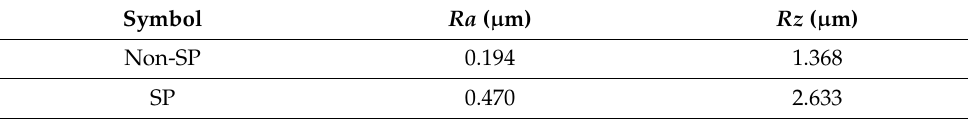
Table 3. Surface roughness values.